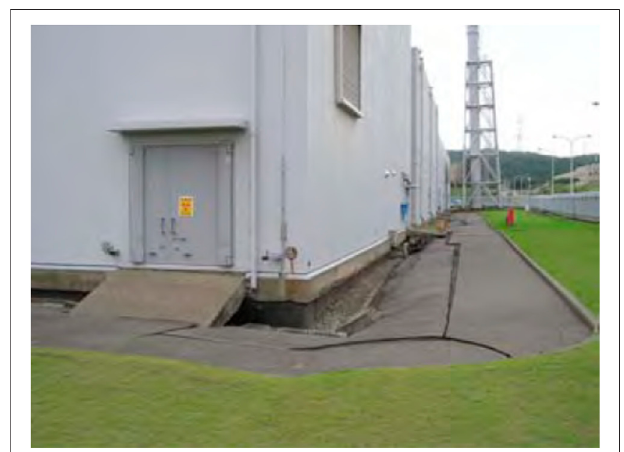
FIGURE 1 | Example of cracks occurring alongside NPP building due to soil settlement below the building (Tokyo Electric Power Company Holdings, Inc.,